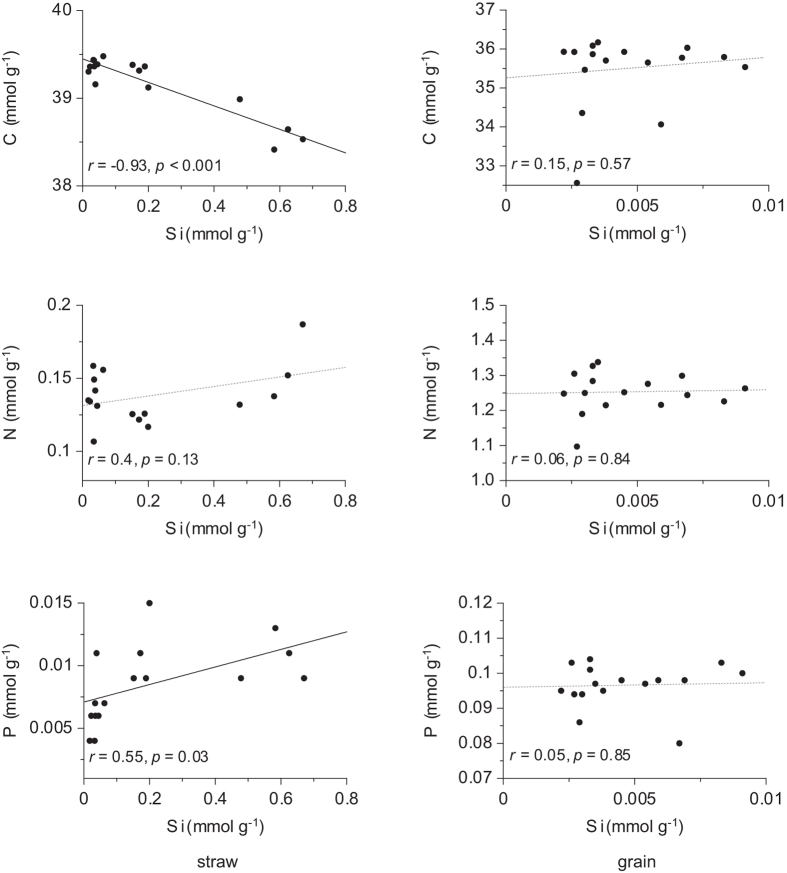
Linear regressions between silicon and nutrient concentration in straw and grain tissue of Triticum aestivum L. cv. Akteur.Pearson´s correlation coefficient (r) and the p-value are shown; significant correlations (p < 0.05) are indicated by black solid lines and non-significant correlations (p > 0.05) by grey dashed lines.